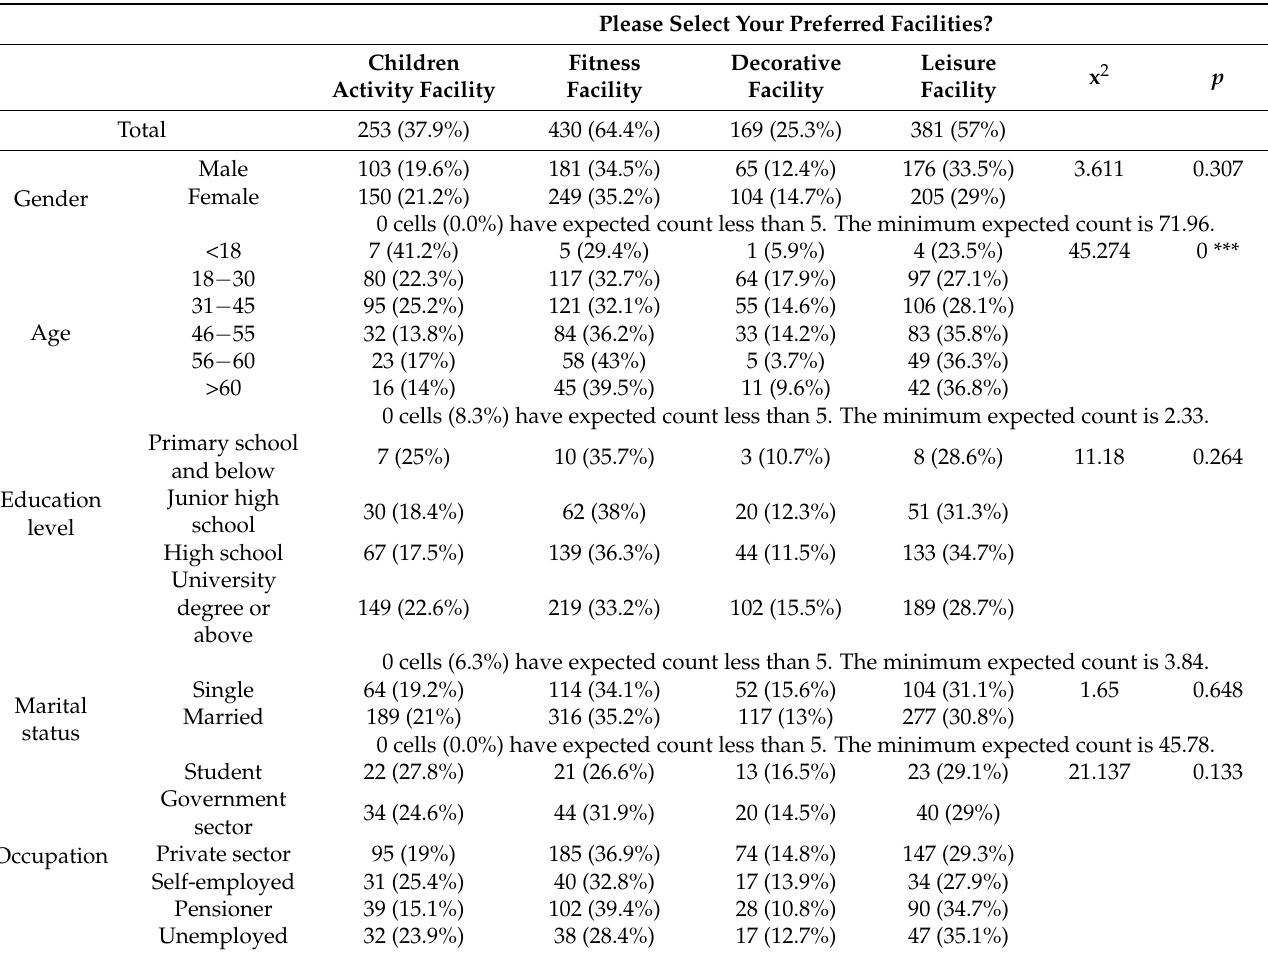
Table A3. The analysis of the hard landscape preferences (chi-square test measure x 2 and p -value). Please Select Your Preferred Facilities? Children